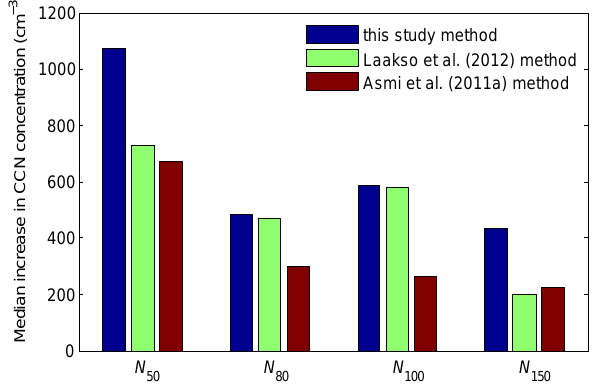
Fig. 7. Median increase in four examined CCN concentrations per cm 3 as a result of nucleation, computed using the method presented in this paper and two other described methods. The Figure is based on a subset of nucleation events in Hyyti¨al¨a in 2002 for which all three methods produced reasonable